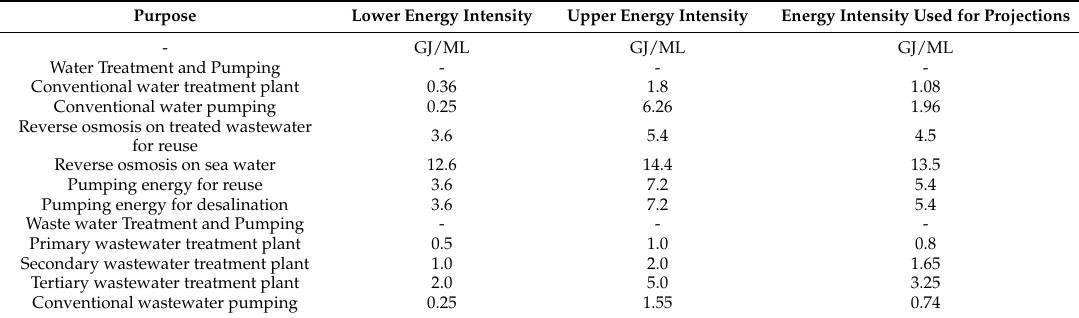
Table 13. Forecasting energy use in 2030 [87].